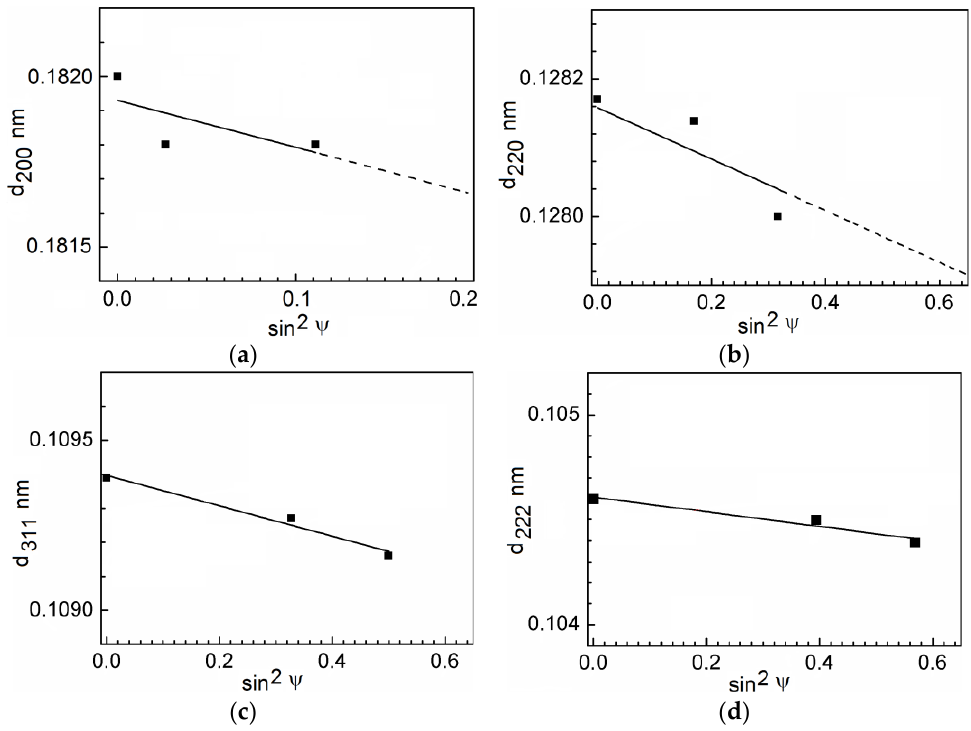
Figure 12. Lattice distances d200 ( a ), d220 ( b ), d311 ( c ), and 222 ( d ) of the Cr-Mn-N steel after its quenching as functions of sin 2 ψ (Со - Kα radiation) [39].